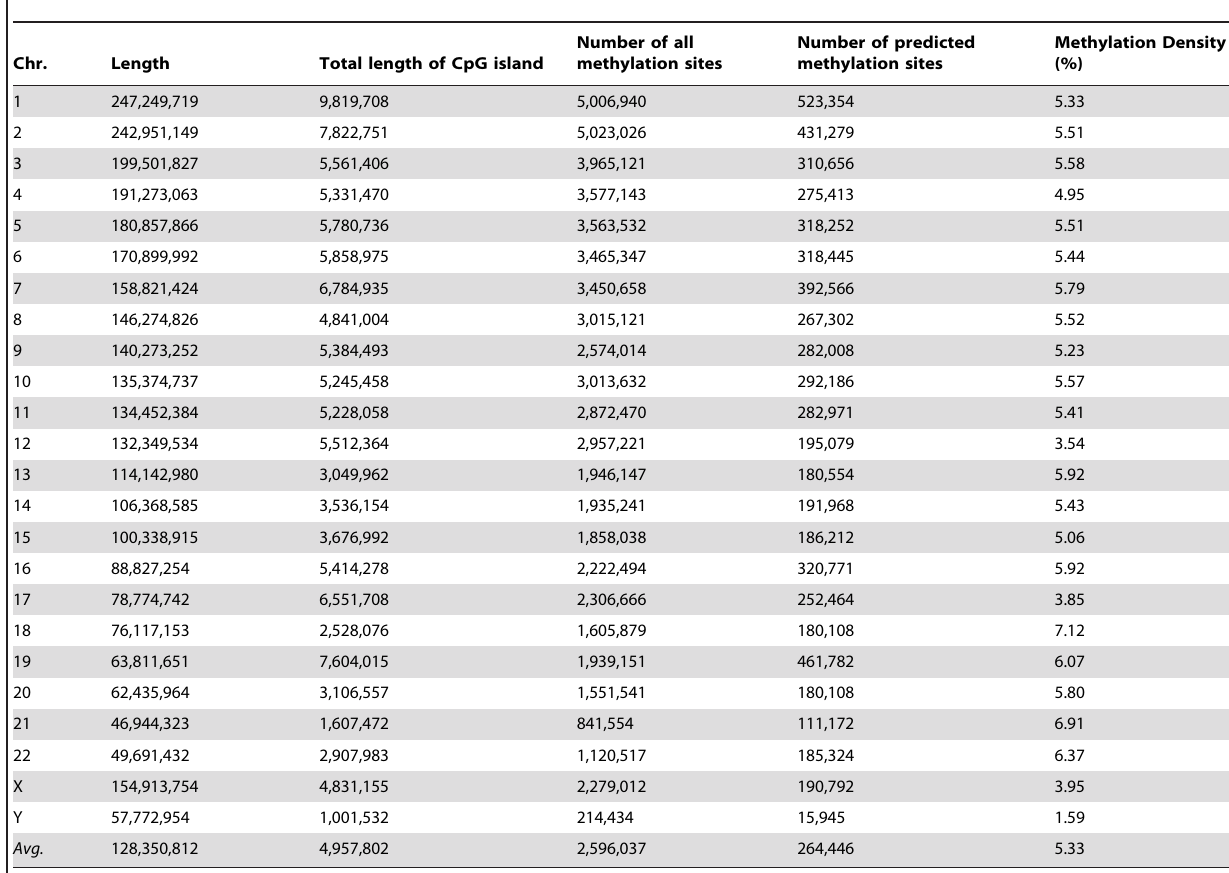
Table 5. Number of methylation sites identified with CPSORL in all chromosomes of the human genome. (NCBI.36) .